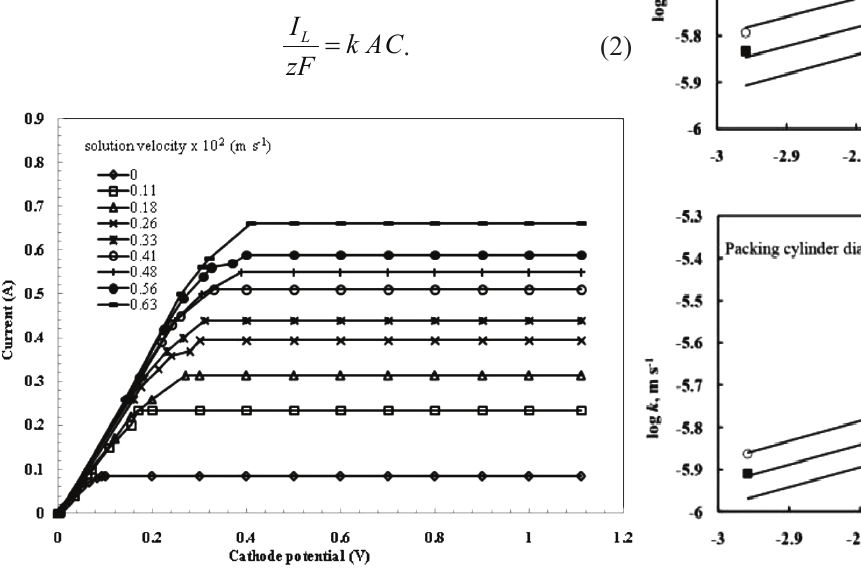
Fig. 3 – log k vs. log V at different Sc numbers (○Sc = 1253, ■Sc = 1821, ∆Sc = 2778) and different packing cylinder diam ­ eter (coil tube diameter = 0.006